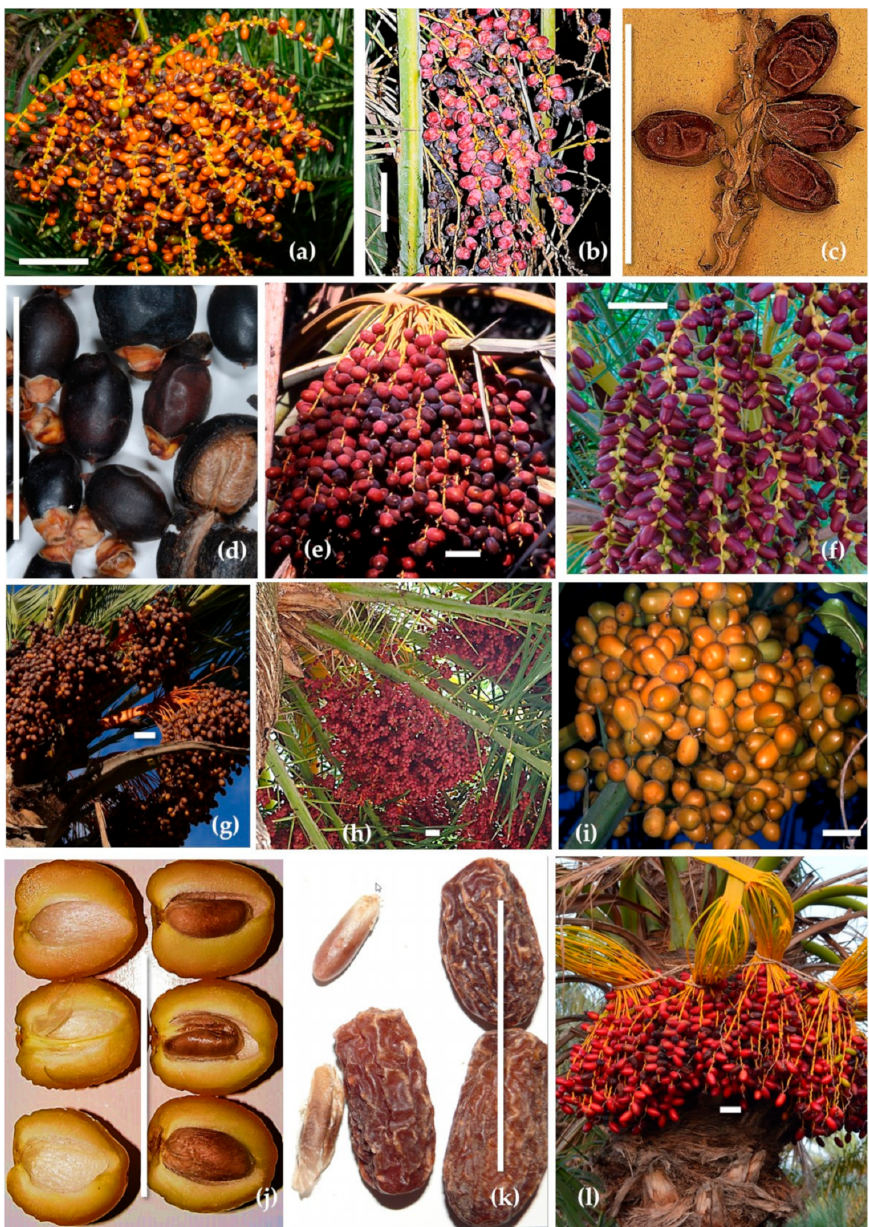
Figure 4. Diversity of Phoenix : fruits. ( a ), Phoenix reclinata (Orihuela, Spain); ( b ), P. “Palmer” (Orihuela, Spain); ( c ), P. acaulis (India); ( d ), P. hanceana (Riverside, USA); ( e ), P. dactylifera Eastern Group (E_DAC) (Palmyra, Syria); ( f ), P. roebelenii (Jardines de Albarda, Pedreguer, Spain); ( g ), P. dactylifera “Negros” Western Group (W_DAC) (Orihuela, Spain); ( h ), P. canariensis var. porphyrococca (Menton, France); ( i ), P. dactylifera Eastern Group (E_DAC) (Palmyra, Syria); ( j ), P. dactylifera “Barhee” Eastern Group (E_DAC) (Jordan Valley, Israel); ( k ), P. dactylifera Chowhara-style dehydrated dates Eastern Group (E_DAC) (Pakistan); ( l ), P. dactylifera Eastern Group (E_DAC) (Socotra, Yemen). Abbreviations for the major P. dactylifera geographical groups: E_DAC: North Africa and West Asia P. dactylifera. W_DAC: North Africa and Mediterranean P. dactylifera. Scale bar: 5 cm. Images: ( a , b , d – k ). Diego Rivera and Concepci ó n Ob ó n, ( c ). MNHN/Vascular plants (P)/P01796536 https://science.mnhn.fr/institution/ mnhn/collection/p/item/p01796536?listIndex=11&listCount=16, (accessed on 15 March 2022), ( l ). Joel